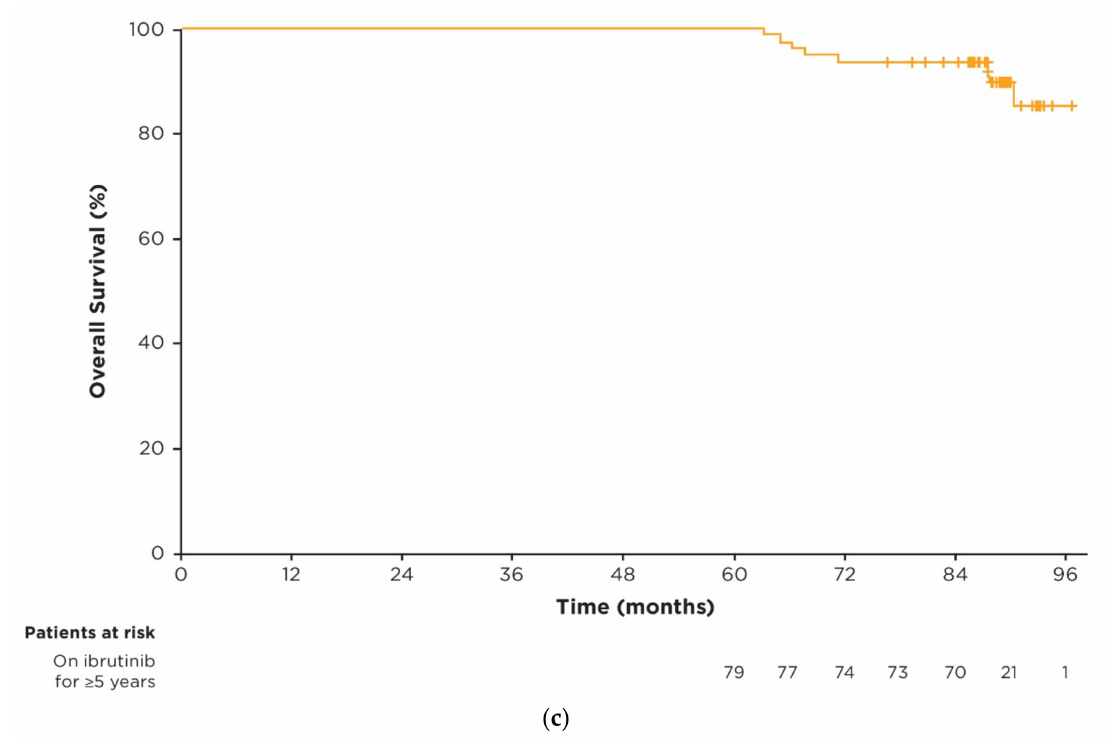
Figure 2. Efficacy in patients on ibrutinib treatment for ≥ 5 years ( n = 79). ( a ) Cumulative best response over time; ( b ) Kaplan–Meier curve of investigator-assessed PFS; ( c ) Kaplan–Meier curve of OS. Percentages of patients in each category of response may not add up to the overall proportion with a response due to rounding. Abbreviations: CR, complete response; CRi, complete response with incomplete bone marrow recovery; nPR, nodular partial response; OS, overall survival; PFS, progression-free survival; PR, partial response; PR-L, partial response with lymphocytosis; SD, stable